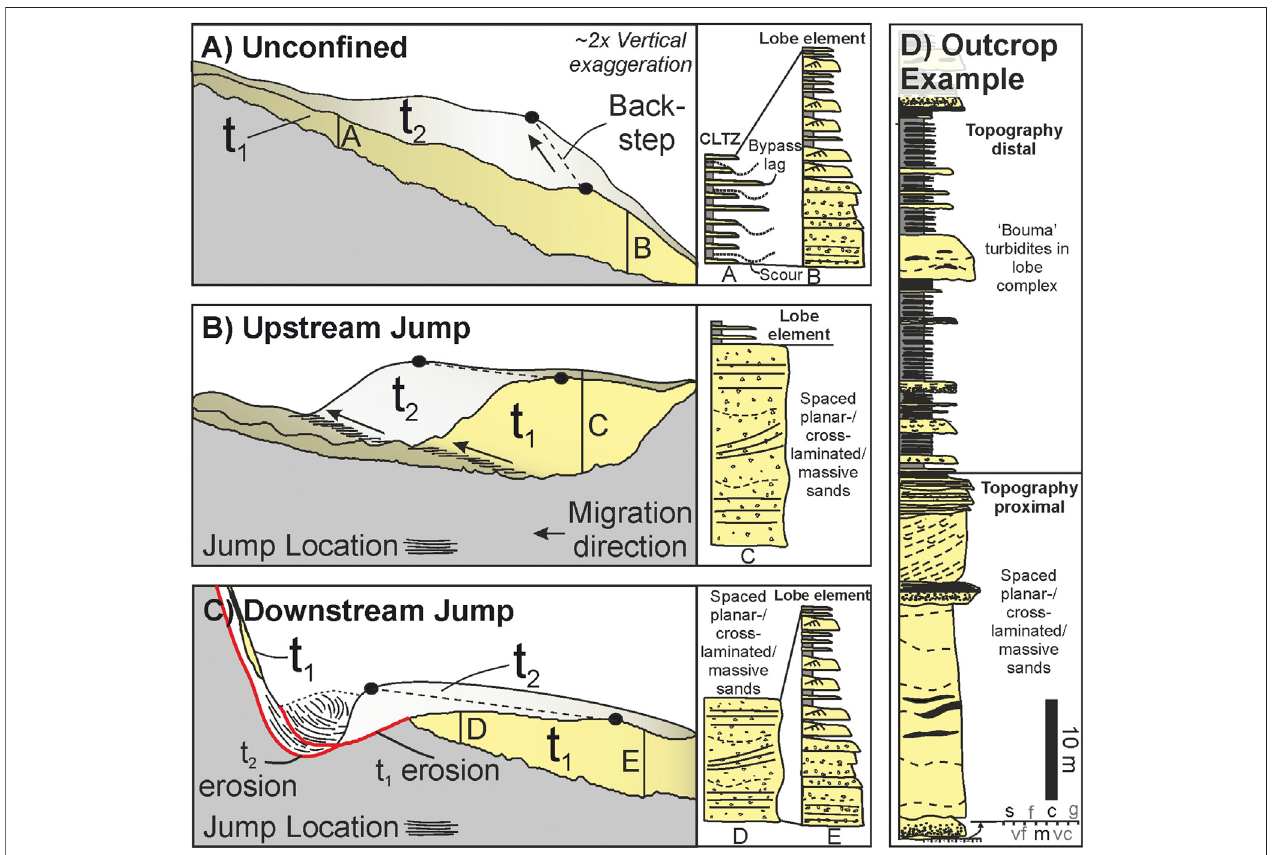
FIGURE 12 | Schematic diagram showing how these experimental deposits (t 1 ; Figures 6 , 7 ) and a hypothetical second deposit (t 2 ) may scale to natural lobe elementstackingpatternsandfacies.Faciesmodi fi edfromPrélatetal.,2009,PostmaandCartigny,2014,Hageetal.,2018,andSoutteretal.,2019. (A) Back-stepping of lobe elements caused by the depositional relief of the underling deposit. (B,C) Major back-stepping caused by an upstream hydraulic jump (B) or downstream (C) hydraulic jumps and erosion. These jumps form due to rapid deceleration at counter-slopes. The second deposit (t 2 ) in A, B and C is hypothetical. (D) Logged section from the Annot Basin (modi fi ed from Soutter et al., 2019; Braux Fault, 43 ° 59 ′ 3.84 ″ N/6 ° 42 ′ 50.76 ″ E), showing the potential fi eld expression of proximal hydraulic jump and/or highly con fi ned deposition passing into distal hydraulic jump and/or weakly con fi ned